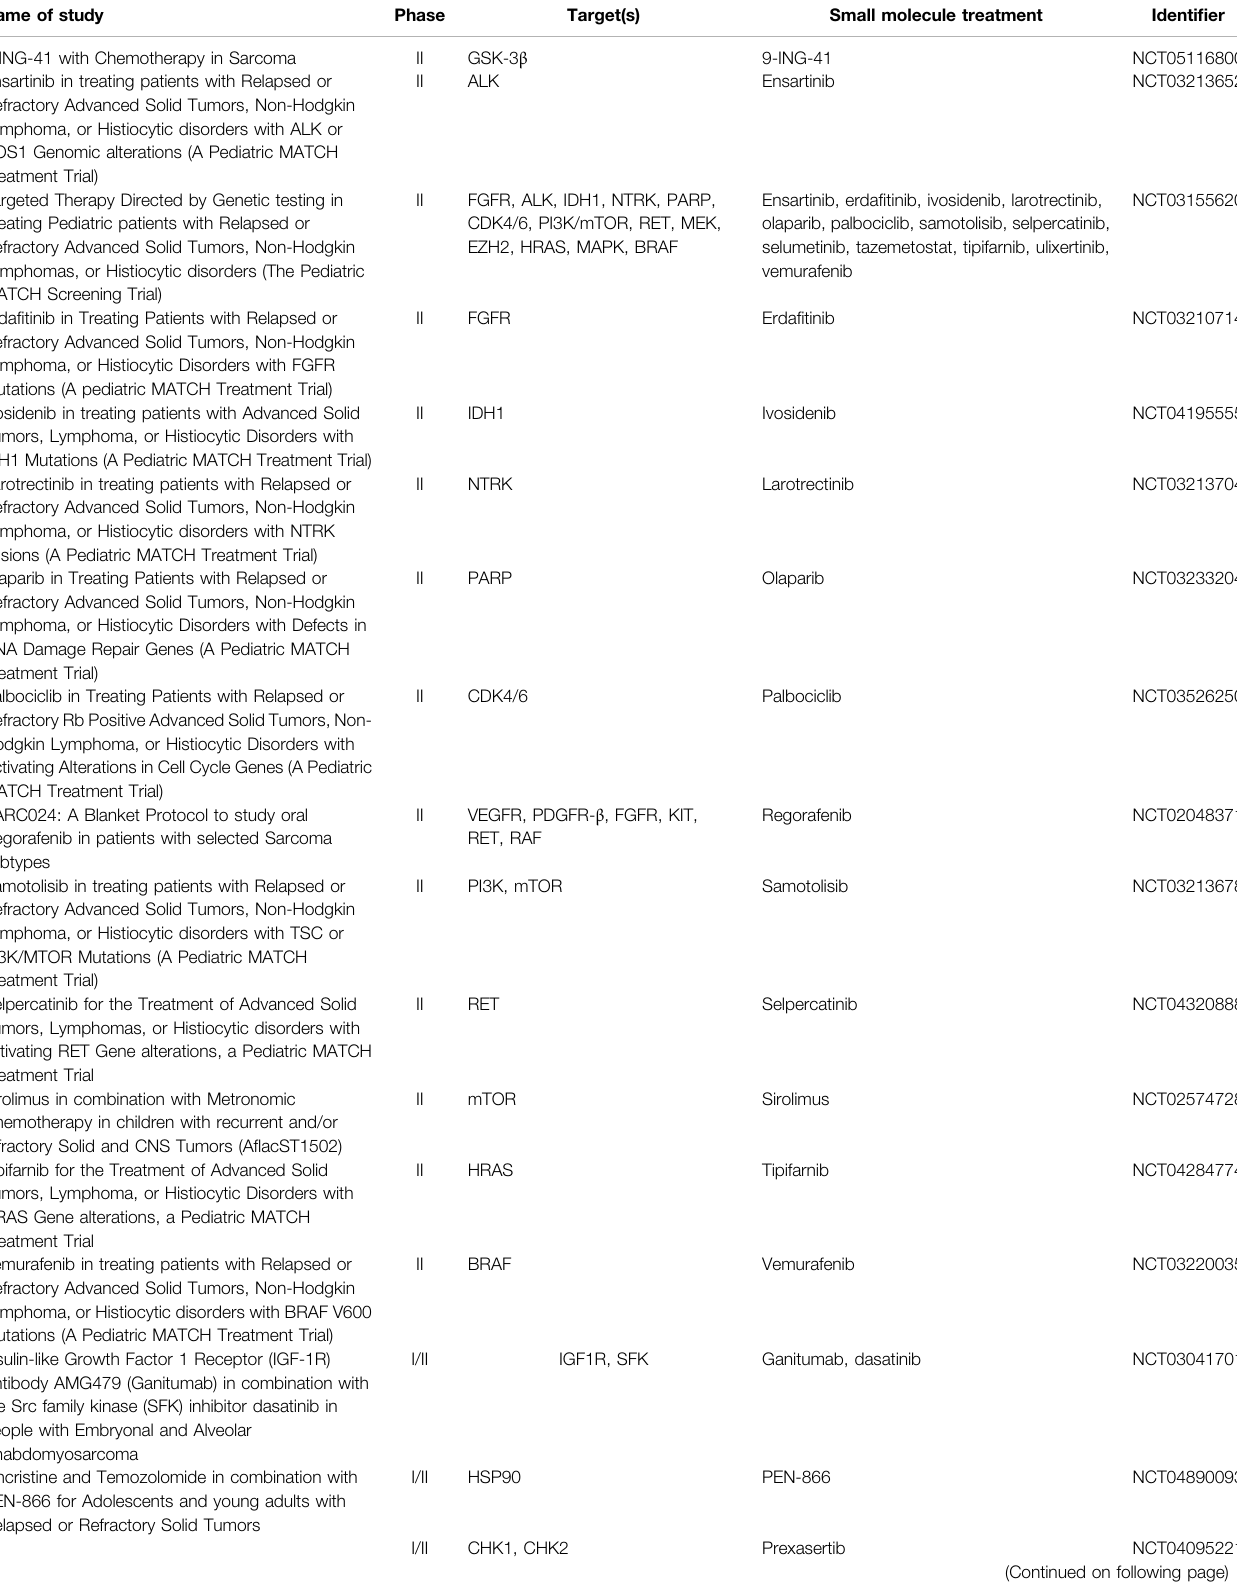
TABLE 3 | Small Molecule Clinical Trials that are Recruiting or Active for Pediatric and Adolescent Rhabdomyosarcoma Patients (All Data from